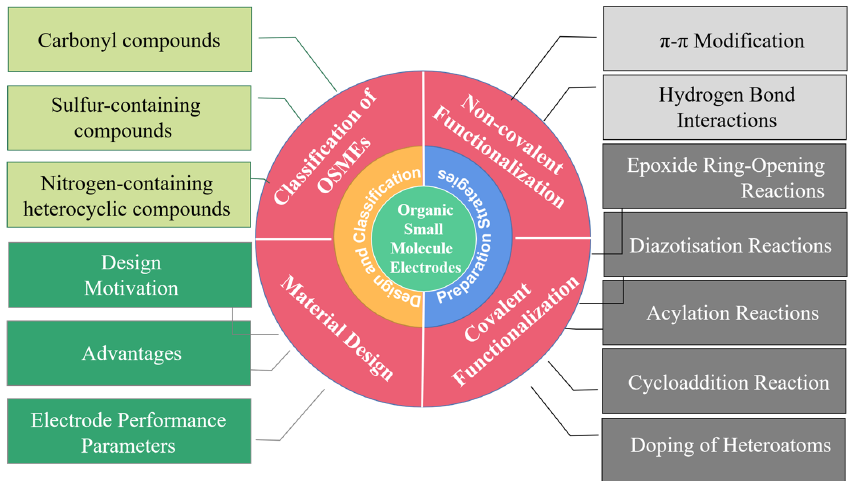
Figure 1. Preparation strategies, design, and classification of organic small-molecule electrodes for supercapacitor applications.